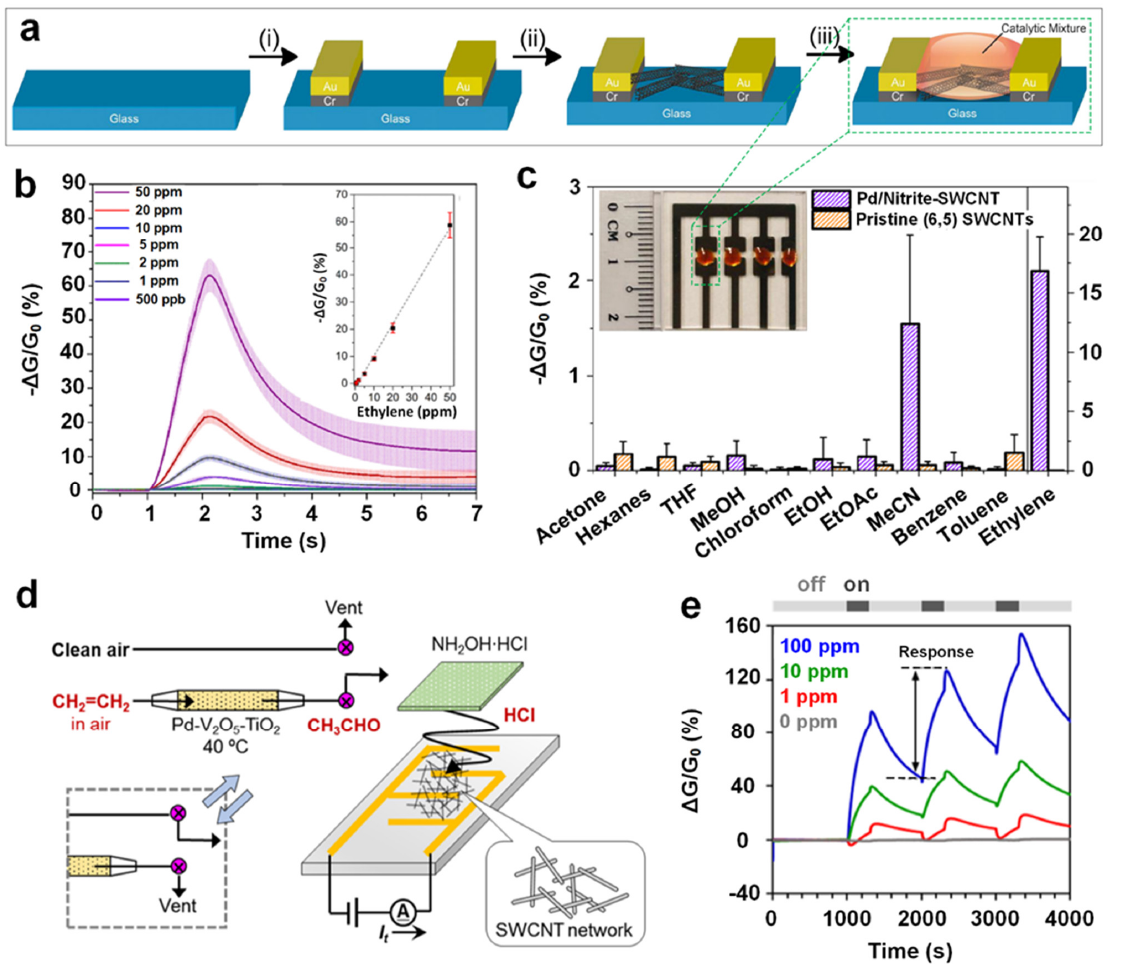
Figure 8. ( a ) Schematic workflow of the liquid/solid device fabrication: (i) electrodes deposition via thermal evaporator, (ii) SWCNTs are deposited between the electrodes via drop casting, and finally (iii) the reaction mixture is added on top of the SWCNTs. ( b ) Sensing dynamic curves and (inset) the plot of response against ethylene gas at varied concentrations. ( c ) The selectivity of the gas sensor toward a wide range of gases including ethylene. Inset: the photograph of SWCNTs with the liquid mixture deposited between Au electrodes on glass. Reproduced from Ref. [16] with permission from the American Chemical Society. ( d ) Pictorial illustration of the sensing system and ( e ) the sensing dynamic curves. Reproduced from Ref. [50] with permission from the American Chemical Society. As a nonpolar and small molecule, ethylene gas is difficult to detect directly [4]. How- ever, its hydroformylated and/or ketonized by-products via the Wacker oxidation reac- tion (e.g., the production of acetaldehyde: C 2 H 4 + 1/2O 2 → CH 3 CHO) are relatively active due to their reactive radicals (e.g., carbonyl group) [79] and thus should be easier to be